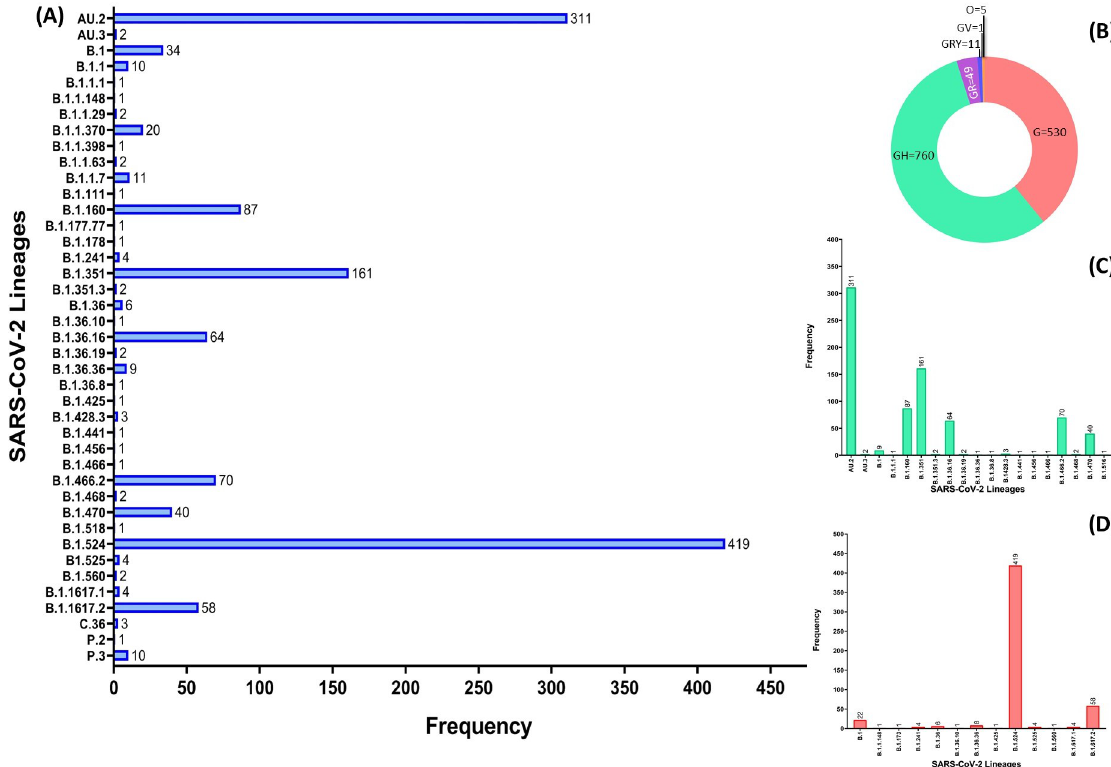
Fig 1. SARS-CoV-2 D614G variant lineages and clades distribution in Malaysia. (A) Distribution of lineages of SARS-CoV-2 D614G variant from Malaysia deposited in GISAID until July 5, 2021 (n = 1356). (B) Donut diagram showing clade distribution of D614G variants from Malaysia deposited in GISAID until July 19, 2021 (C) Lineages clustered in clade GH (D) Lineages clustered in clade